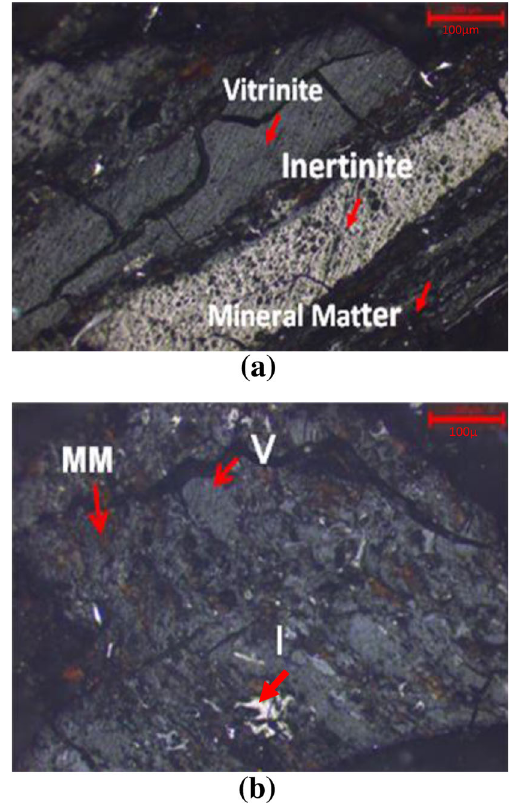
Fig. 1 Microphotographs of coal